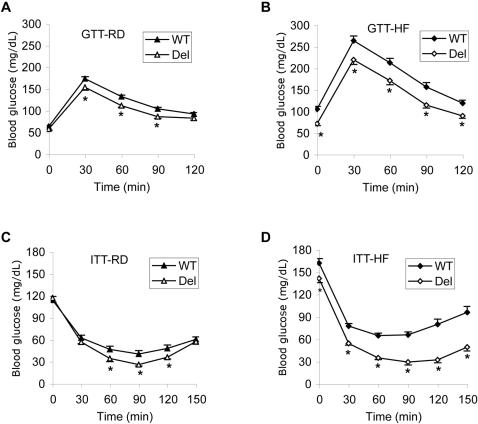
Glucose and insulin tolerance tests of male mice.A. Glucose tolerance test (GTT) for mice on regular diet (RD) at 6 months of age. Mice were injected with 1 g/kg glucose at time zero after 16 hr overnight fasting and serum glucose was measured for up to 2 h. n = 13 WT, 9 Del). Deletion mice were better able to clear the glucose that WT, P<0.05 at 30 min, and P<0.001 at 60 and 90 min time points). B. Glucose tolerance test for mice after 4 months on HF diet (n = 16) starting from 8 weeks of age (P<0.01 for all time points). C. Insulin tolerance test (ITT) for mice on regular diet (RD) at 6 months of age. Wild type (n = 13) and mutant (n = 9) mice were injected with 1.6 U/kg insulin at time zero after 5 hr fasting from the onset of the light cycle (P<0.05 at 60, 90 and 120 min). D. Insulin tolerance test for 6-months old mice after 4 months of HF diet. WT mice (n = 15) and deletion mice (n = 16) were injected with 2 U/kg insulin (P<0.02 at time 0, and P<0.0002 at all other time points). Deletion males were more sensitive to insulin than WT.